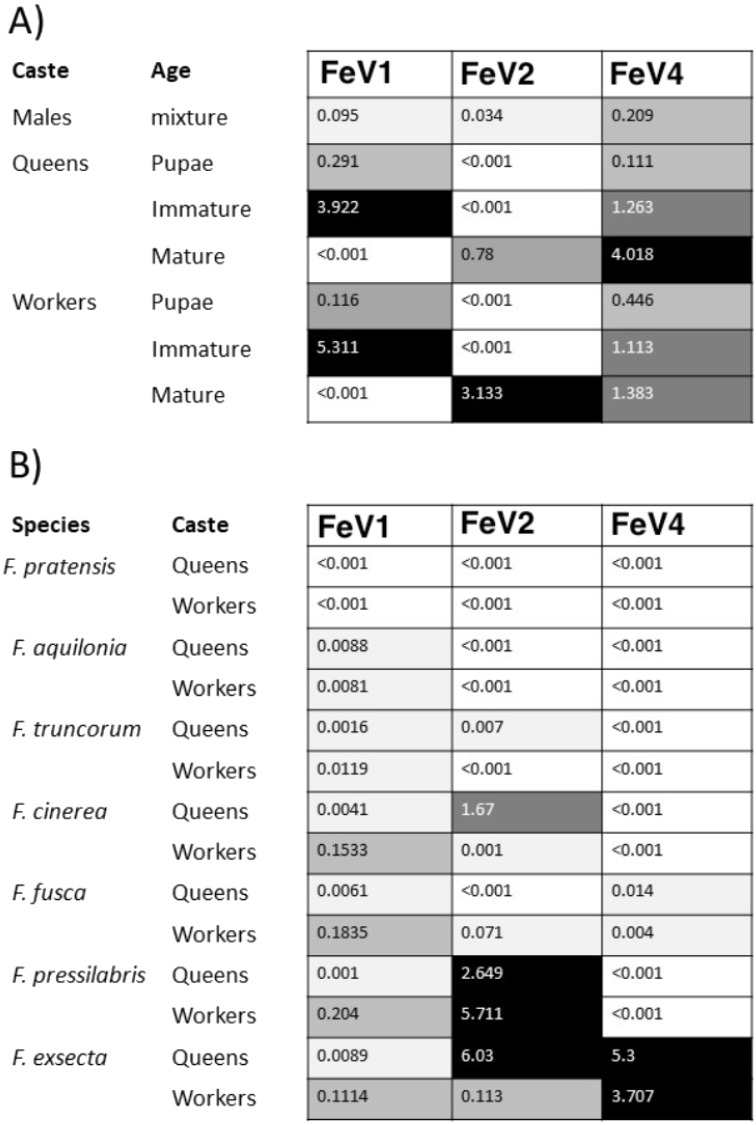
Heat map showing the viral RNA levels of FeV1, FeV2, and FeV4 in different castes and age classes of F. exsecta (A), and in Formica species (raw data from Morandin et al., 2016) (B). The heat map is based on transformed (LNx+1) RPKM values (Tables S6, and S7). Values below 0.001 were classified as having no virus RNA.